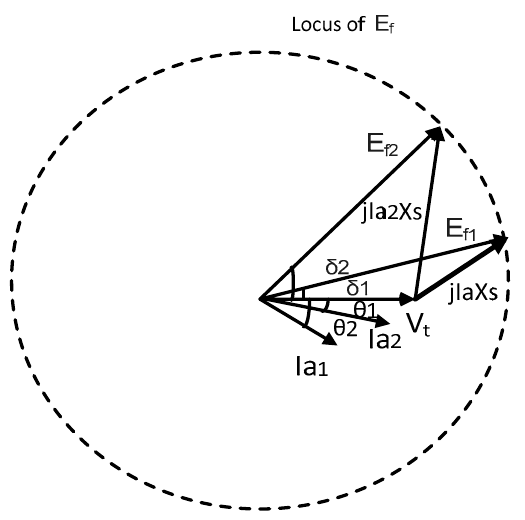
Figure 6. The slack bus performance versus network changes.